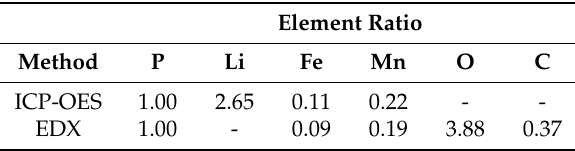
Table 1. Element ratios of acicular crystal sample obtained by ICP-OES and EDX measurements. No values are given if the applied method is not suitable for the detection of the respective element. For each measurement method the element ratio values are normalized to Phosphorus